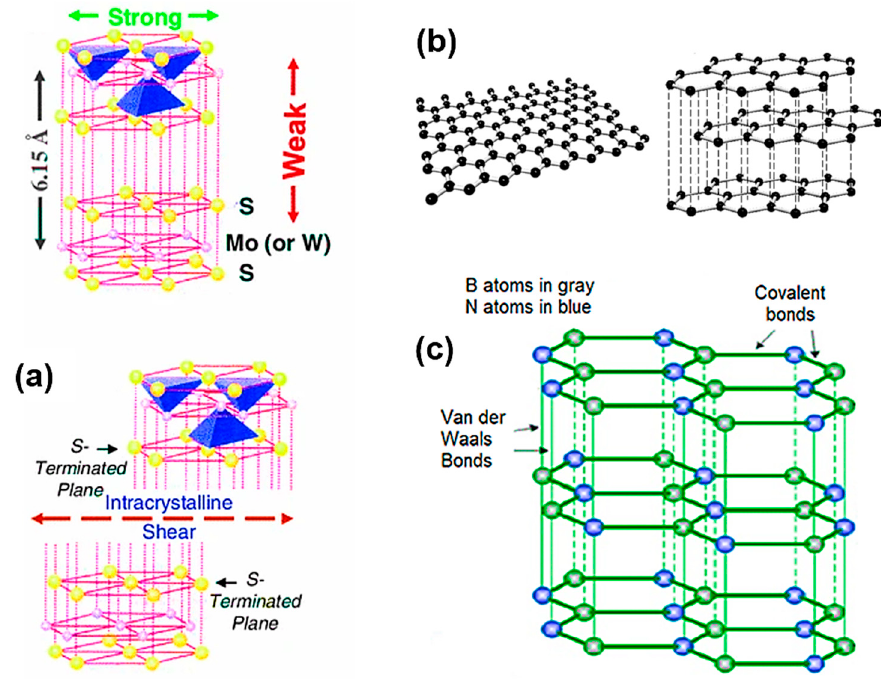
Figure 5. Crystal structures demonstrating the weak Vander walls forces present in the inter-lamellar layers/planers resulting in an easy slip between them ( a ) MoS 2 (or WS 2 ); ( b ) a single layer of graphene and graphite as a heap of multiple graphene layers; and ( c ) hexagonal boron nitride (h-BN) [17].